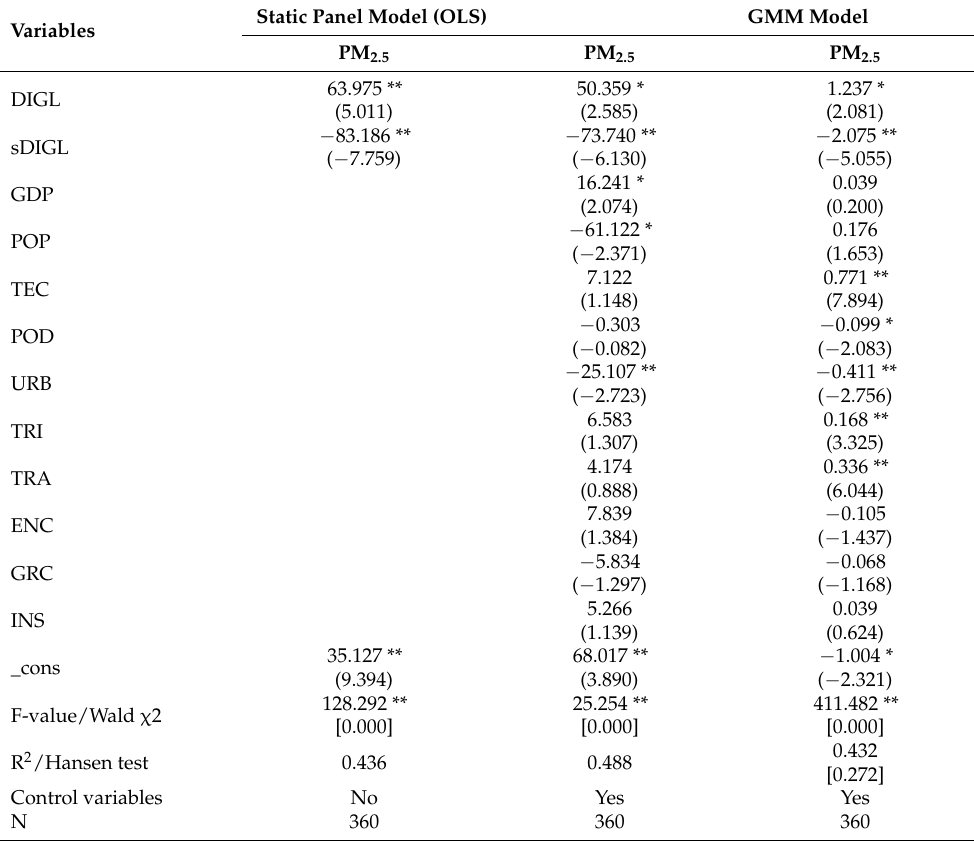
Table 5. Robustness analysis results after adjusting the sample interval.